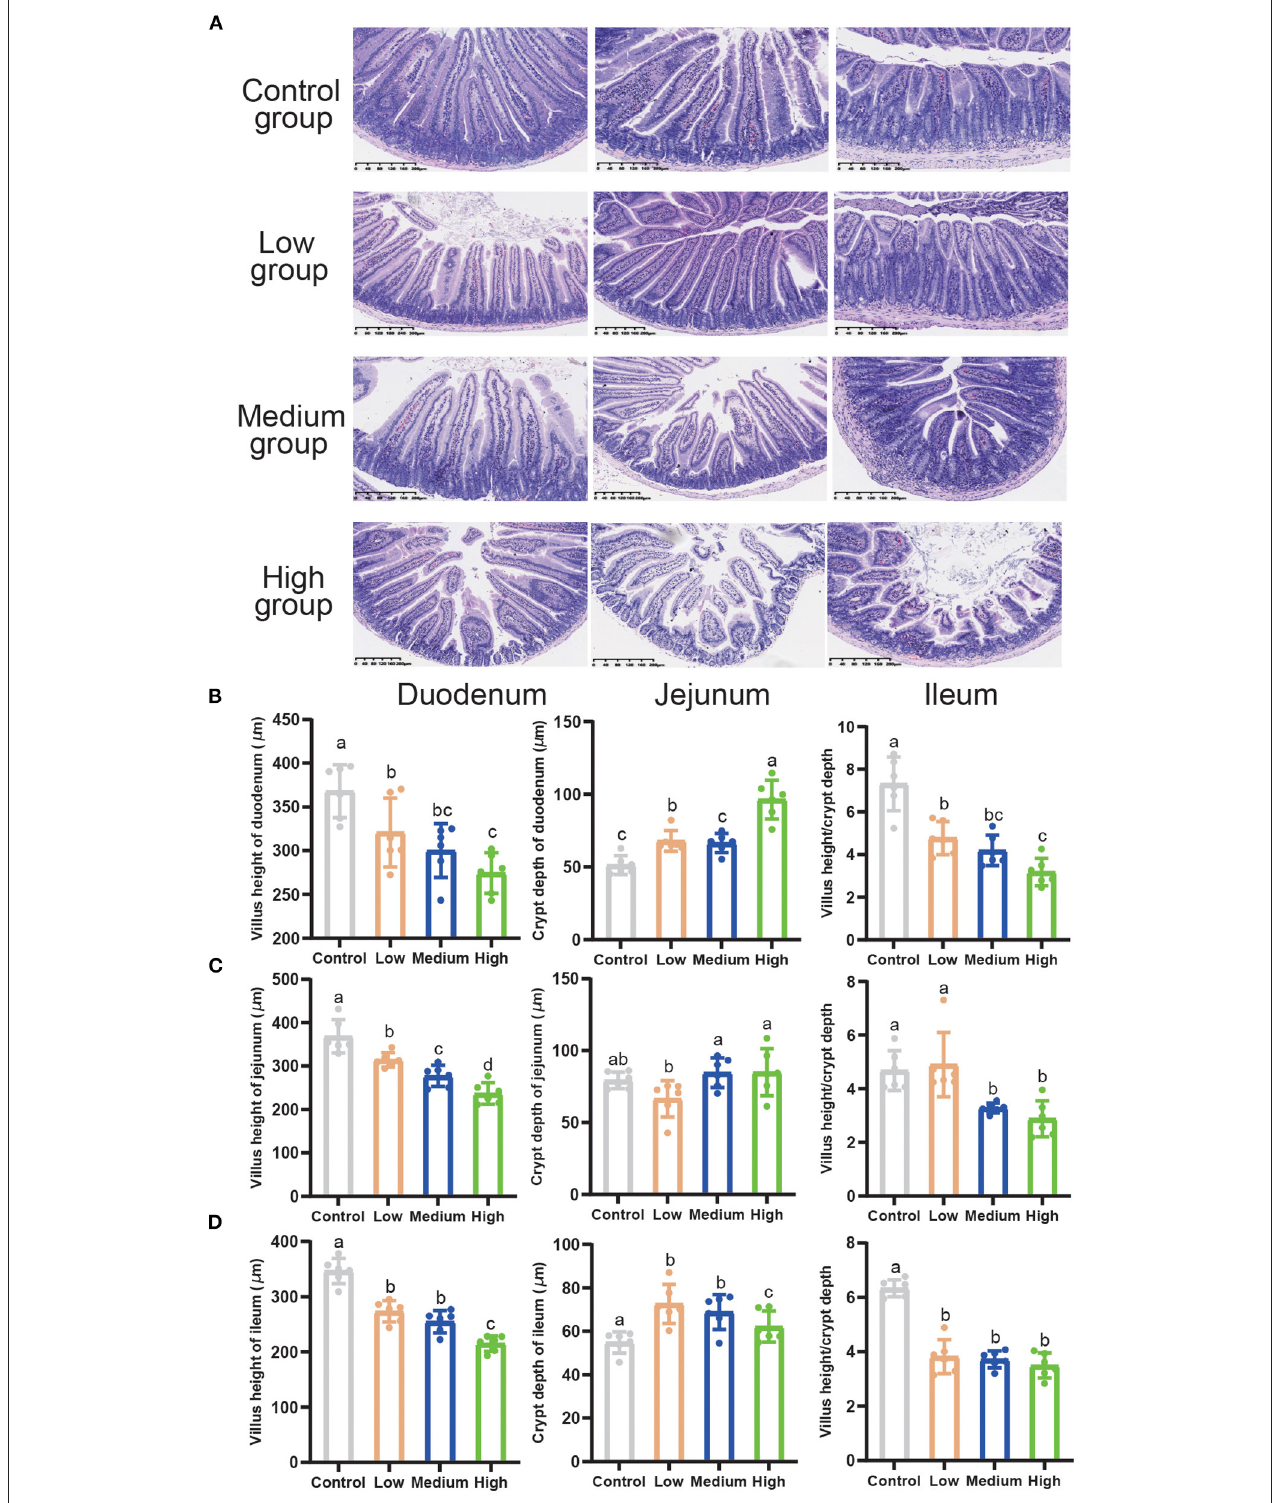
FIGURE 5 | The effects of Clostridium perfringens treatment on the intestines of mice. (A) Duodenum, jejunum, ileum, liver, and spleen were stained with hematoxylin and eosin (H&E) (bars = 330 µ m). (B) Villus height of duodenum, crypt depth of duodenum, and villus height/crypt depth. (C) Villus height of jejunum, crypt depth of jejunum, and villus height/crypt depth. (D) Villus height of ileum, crypt depth of ileum, and villus height/crypt depth. All the values contained six repetitions. a , b , c , d Means values with dissimilar letters were significantly different ( P < 0.05).